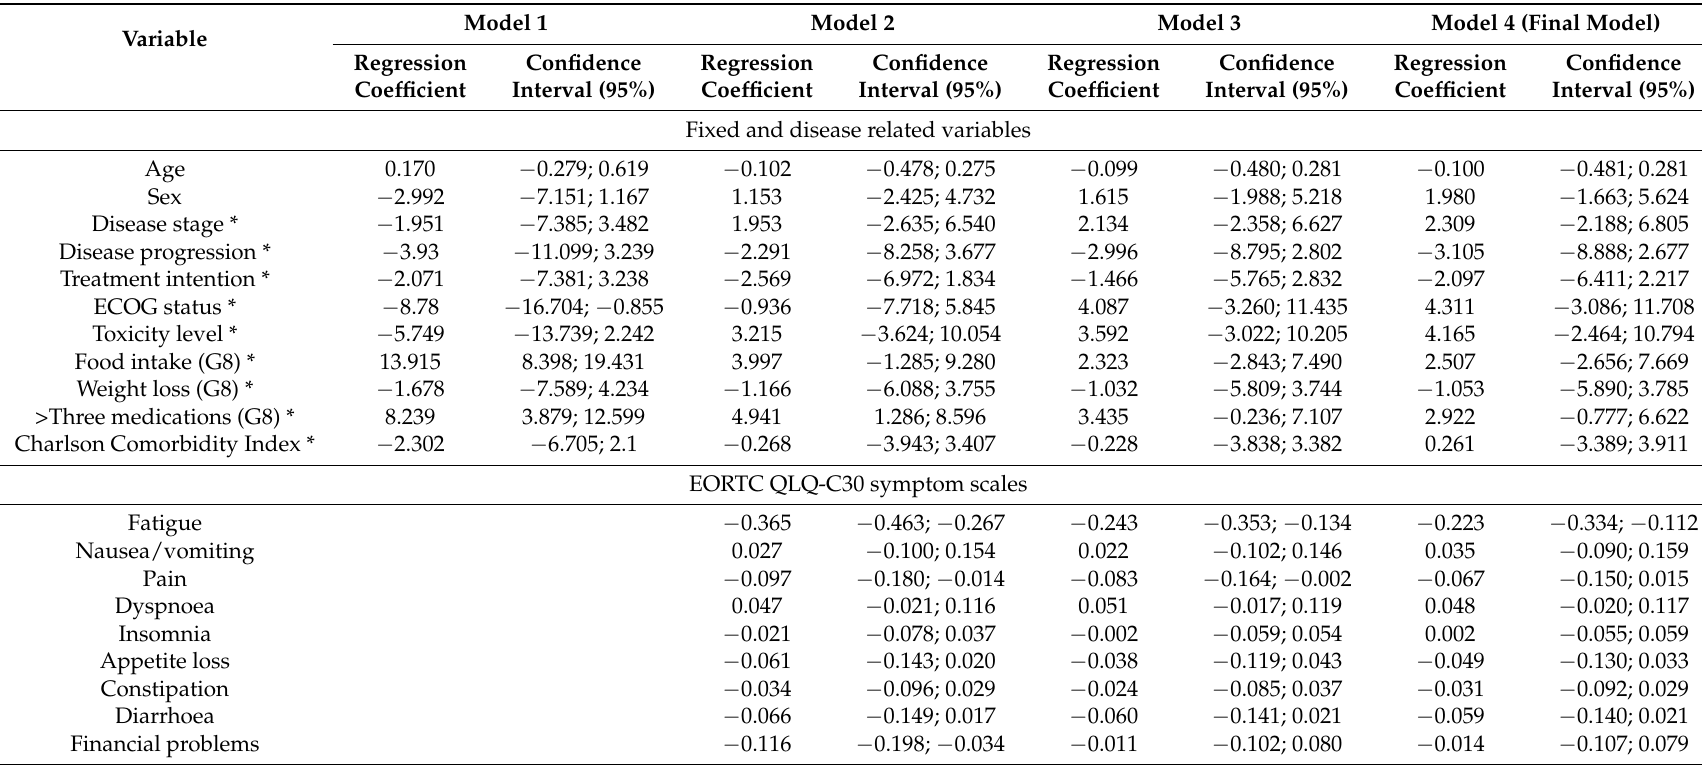
Table 4. Four stepwise regression models with respect to global HRQOL (EORTC QLQ-C30) including fixed and disease related variables, EORTC QLQ-C30 symptom scales, EORTC QLQ-C30 functioning scales and EORTC QLQ-ELD14 scales (for better comparability all models were carried out with the final sample of n = 341